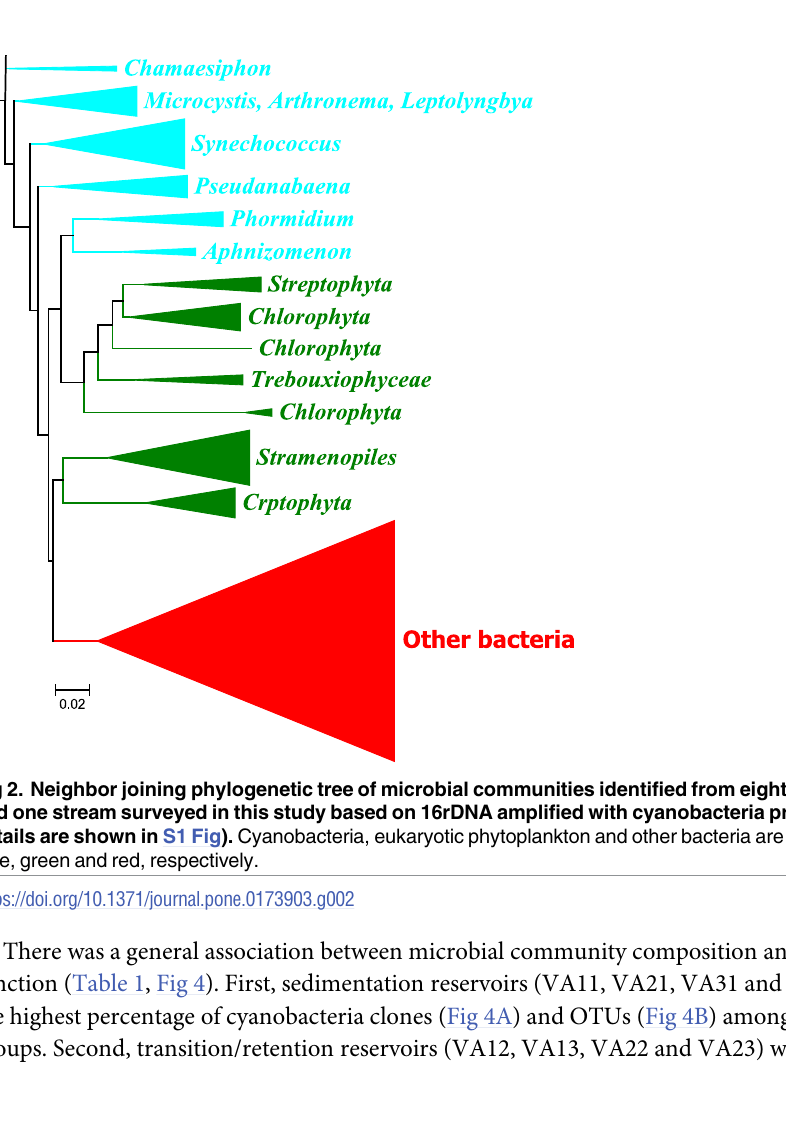
PLOS ONE | https://doi.org/10.1371/journal.pone.0173903 March 16,